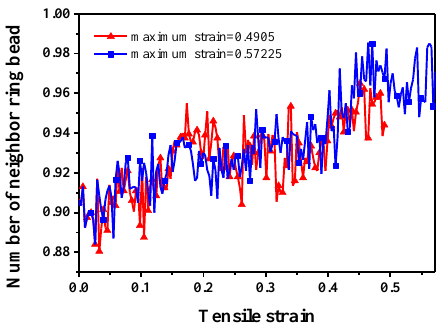
Figure 14. Average number of neighbor ring beads (not including the bead on the same ring) as a function of the strain during the compressive deformation. Two independent compressive deformations are involved in the figure, and the maximum strain is equal to 0.4905 and 0.57225. Meanwhile, the averaged energy of non-bonding interaction, E bond energy, E bond